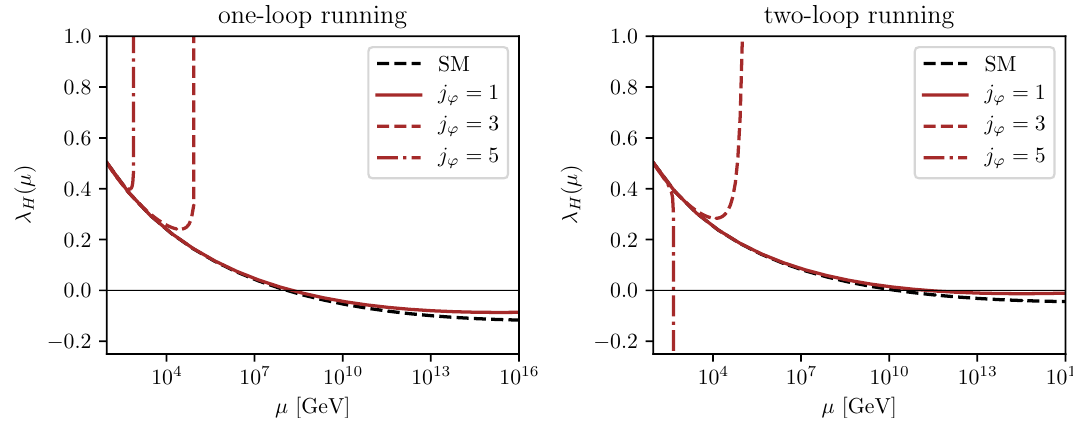
Figure 8. Running of the quartic Higgs coupling (cid:21) H at one-loop (left panel) and two-loop (right panel), for Y ’ = 0. The black dashed line shows the SM result. The brown lines correspond to di(cid:11)erent representations of the complex scalar. Here, we assumed vanishing initial conditions for all non-SM scalar couplings at (cid:22) = M Z